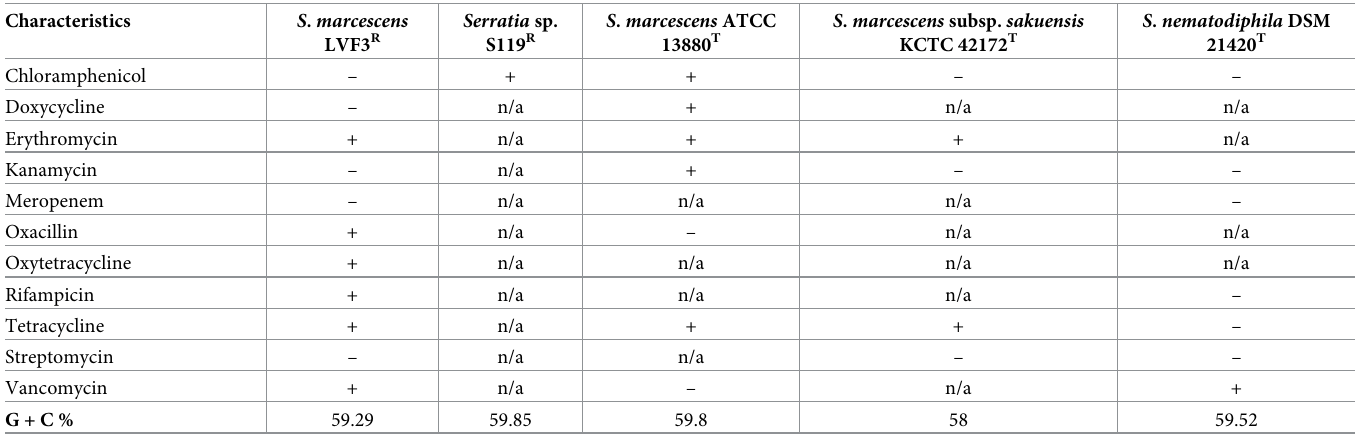
antibiotic andrimid, the cyclic lipopeptide orfamide and the O-antigen of lipopolysaccharides (S3 Table). Andrimid production was also detected in the plant-associated Serratia plymuthica A153 and Serratia marcescens MSU97 [62,63]. Orfamide as a bioactive compound may be released for plant protection [64]. The O-antigen of lipopolysaccharides is responsible for a normal growth rate in plants such as tomatoes